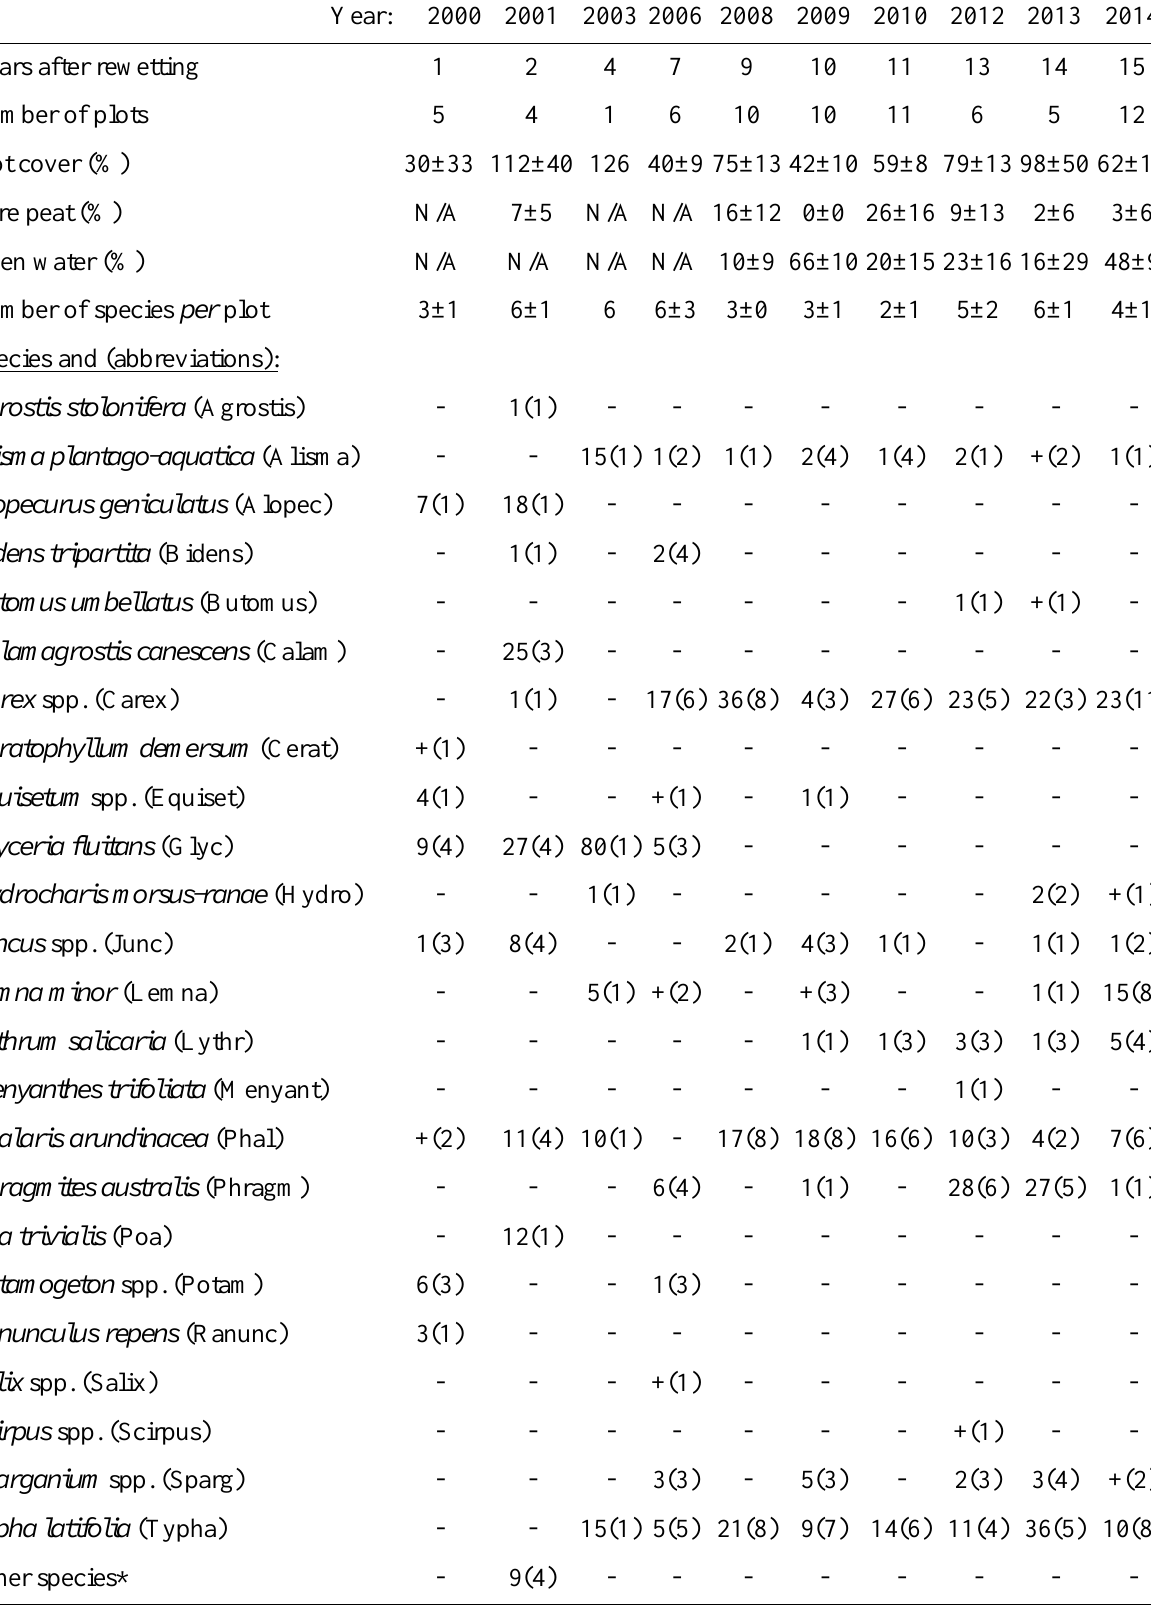
Table 3. Mean cover values (%) recorded through time after rewetting (in 1999) at Västkärr. Confidence intervals (95 %) are shown for plot cover, bare peat, open water and number of species per plot. Species are listed in alphabetical order. For each species, mean cover is calculated across all plots and frequency of appearance (no. plots with a record) is shown in brackets. "+" = cover less than 1 %; * = unidentified